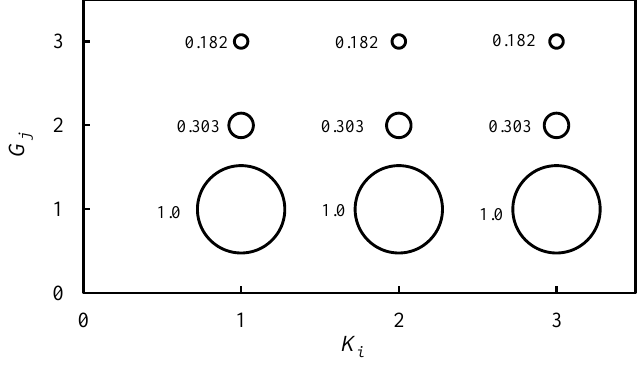
Figure 14. The maximum vertical displacements caused by seabed consolidation due to the cofferdam’s